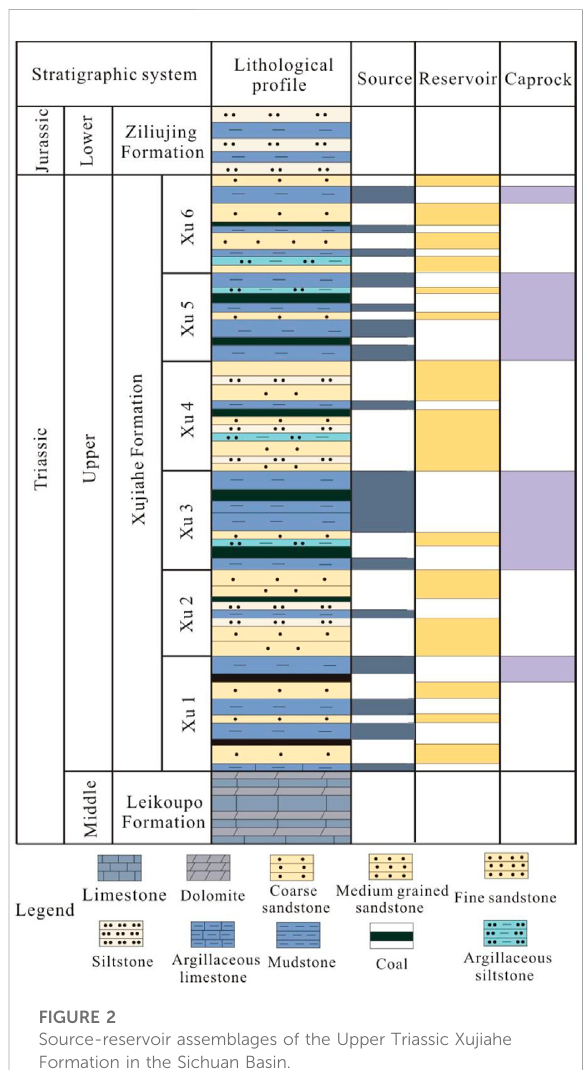
FIGURE 2 Source-reservoir assemblages of the Upper Triassic Xujiahe Formation in the Sichuan